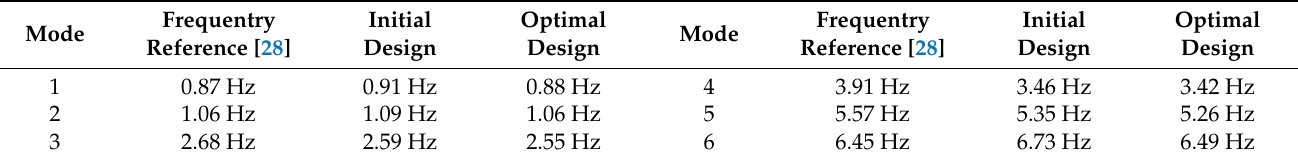
Table 2. Comparison between the reference and optimal blade